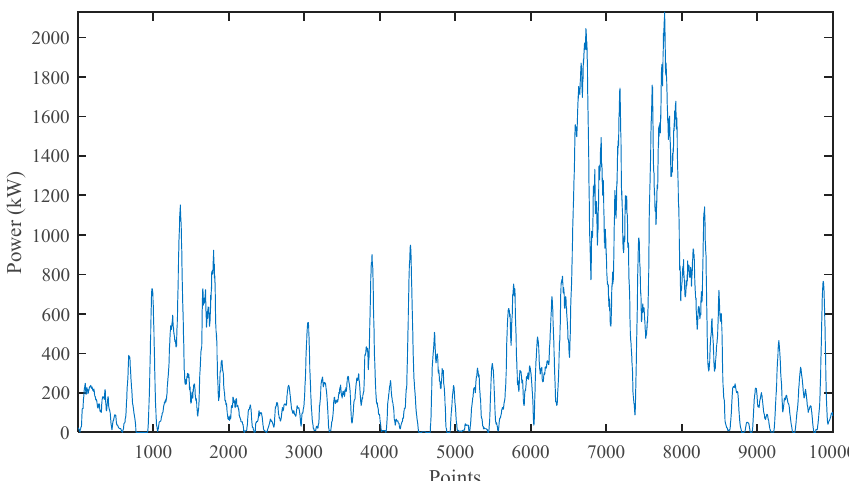
Figure 12. Actual wind speed of the wind turbine (Case 2).